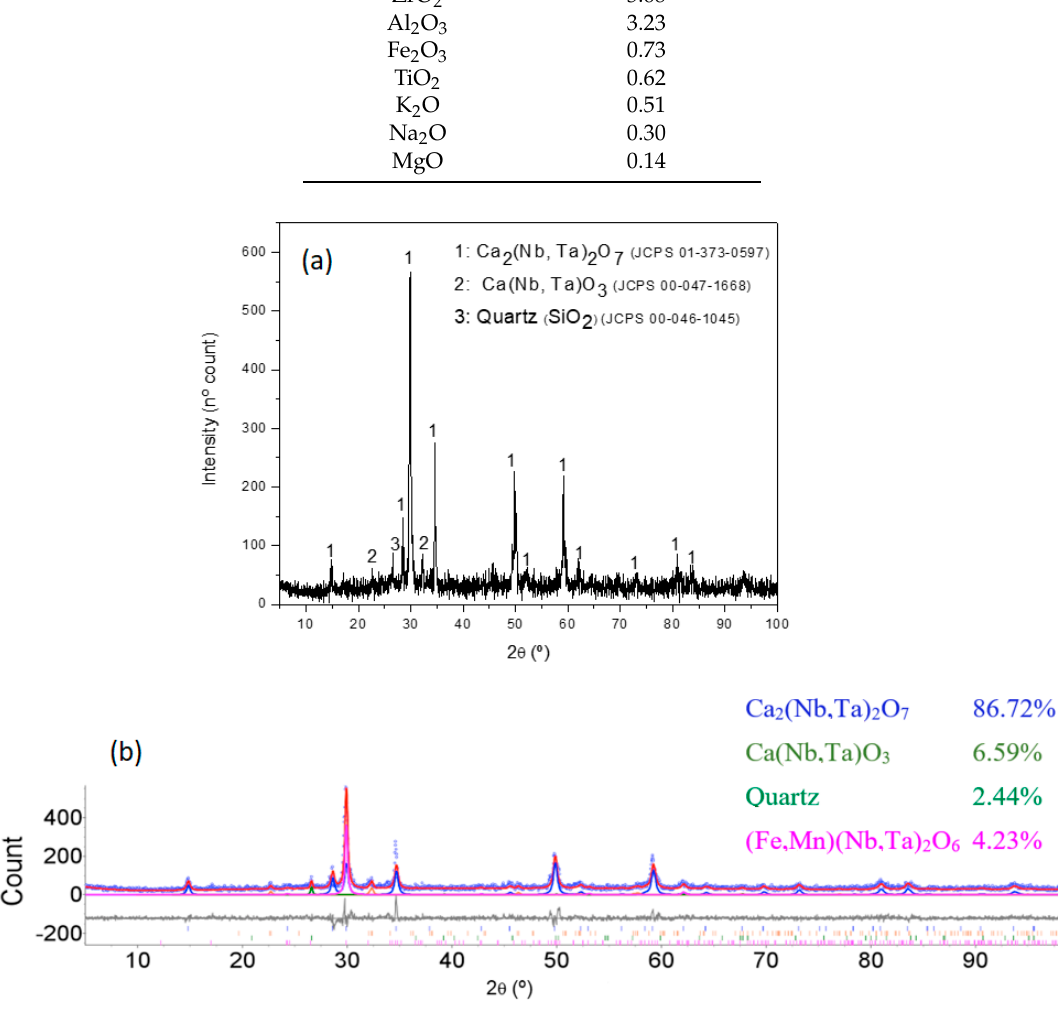
Figure 7. XRD pattern ( a ) and Rietveld fit for the X-ray diffractogram of the slag ( b ).